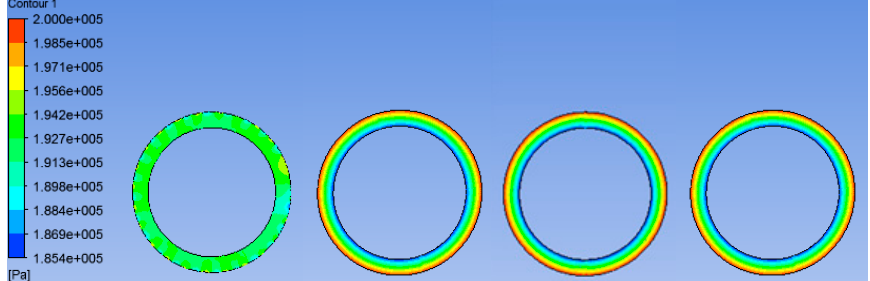
Figure 13. The pressure of 2, 3, 4 and 5 μ m fluid film.